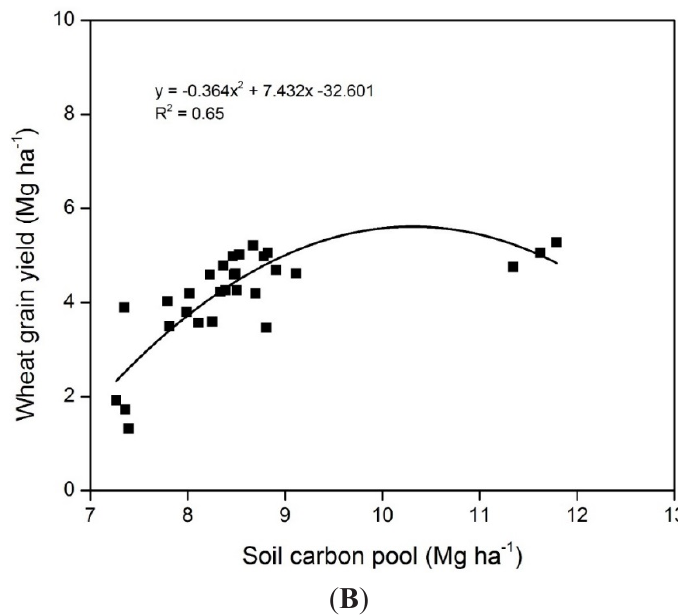
Figure 5. ( A ) and ( B ) Relationship between crop yields and soil organic carbon